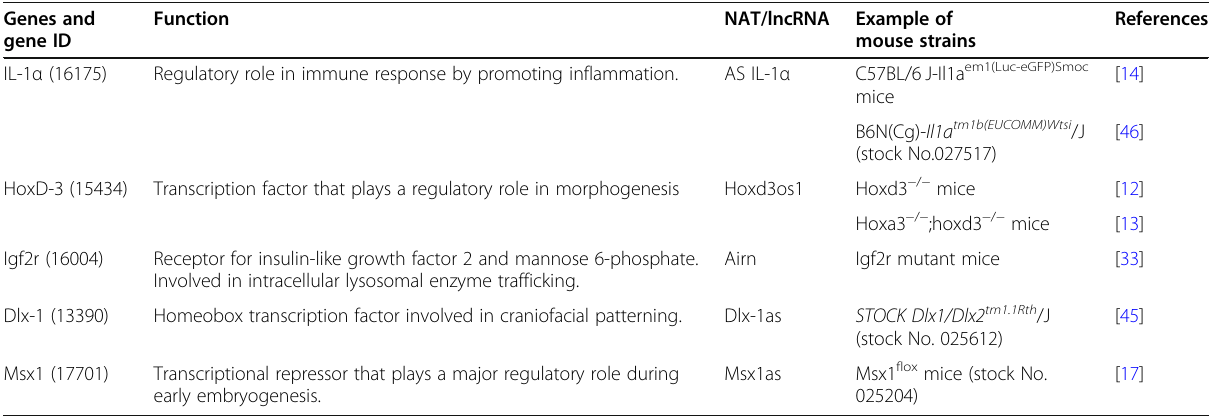
Table 3 Genes, NATs, lncRNAs, and corresponding mice. List of mouse strains showing probable inadvertent partial/complete disruption of overlapping sequence of NATs on the antisense strand along with intended target genes Genes and gene